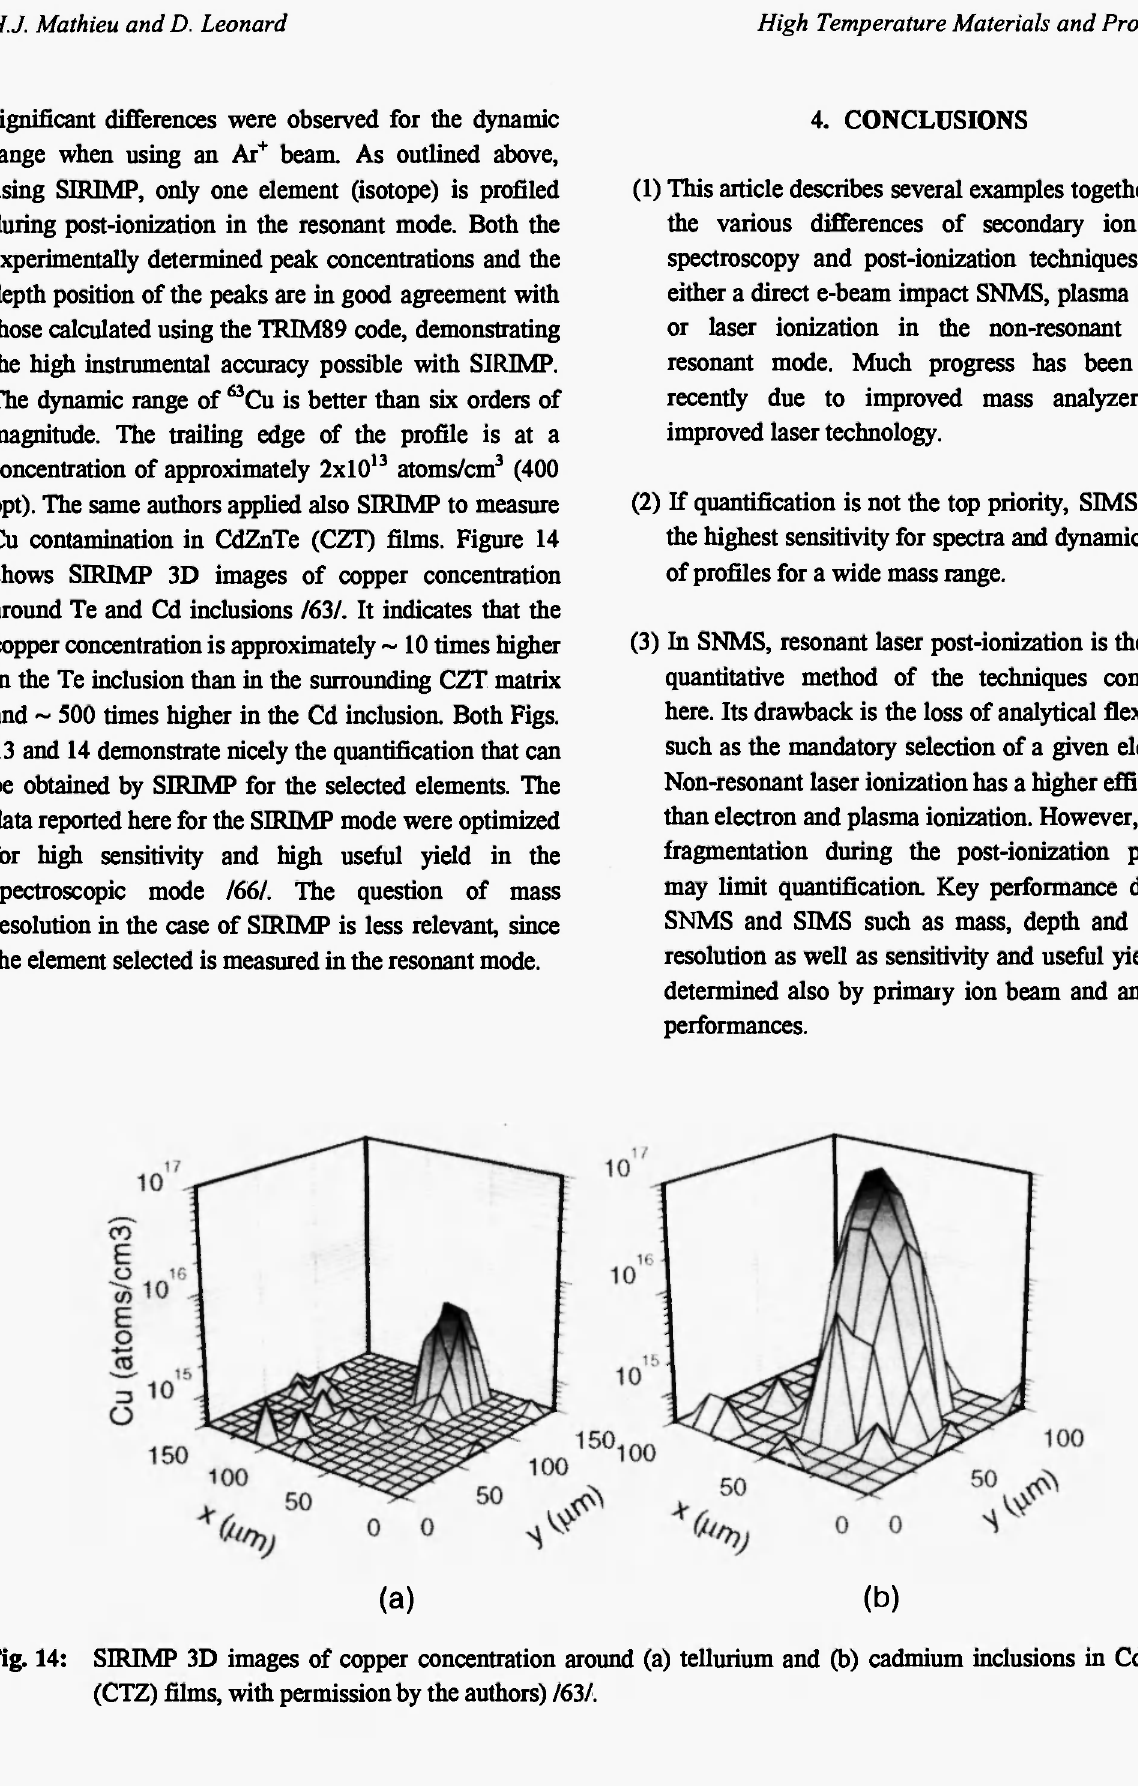
Fig. 14: SIRIMP 3D images of copper concentration around (a) tellurium and (b) cadmium inclusions in CdZnTe (CTZ) films, with permission by the authors)